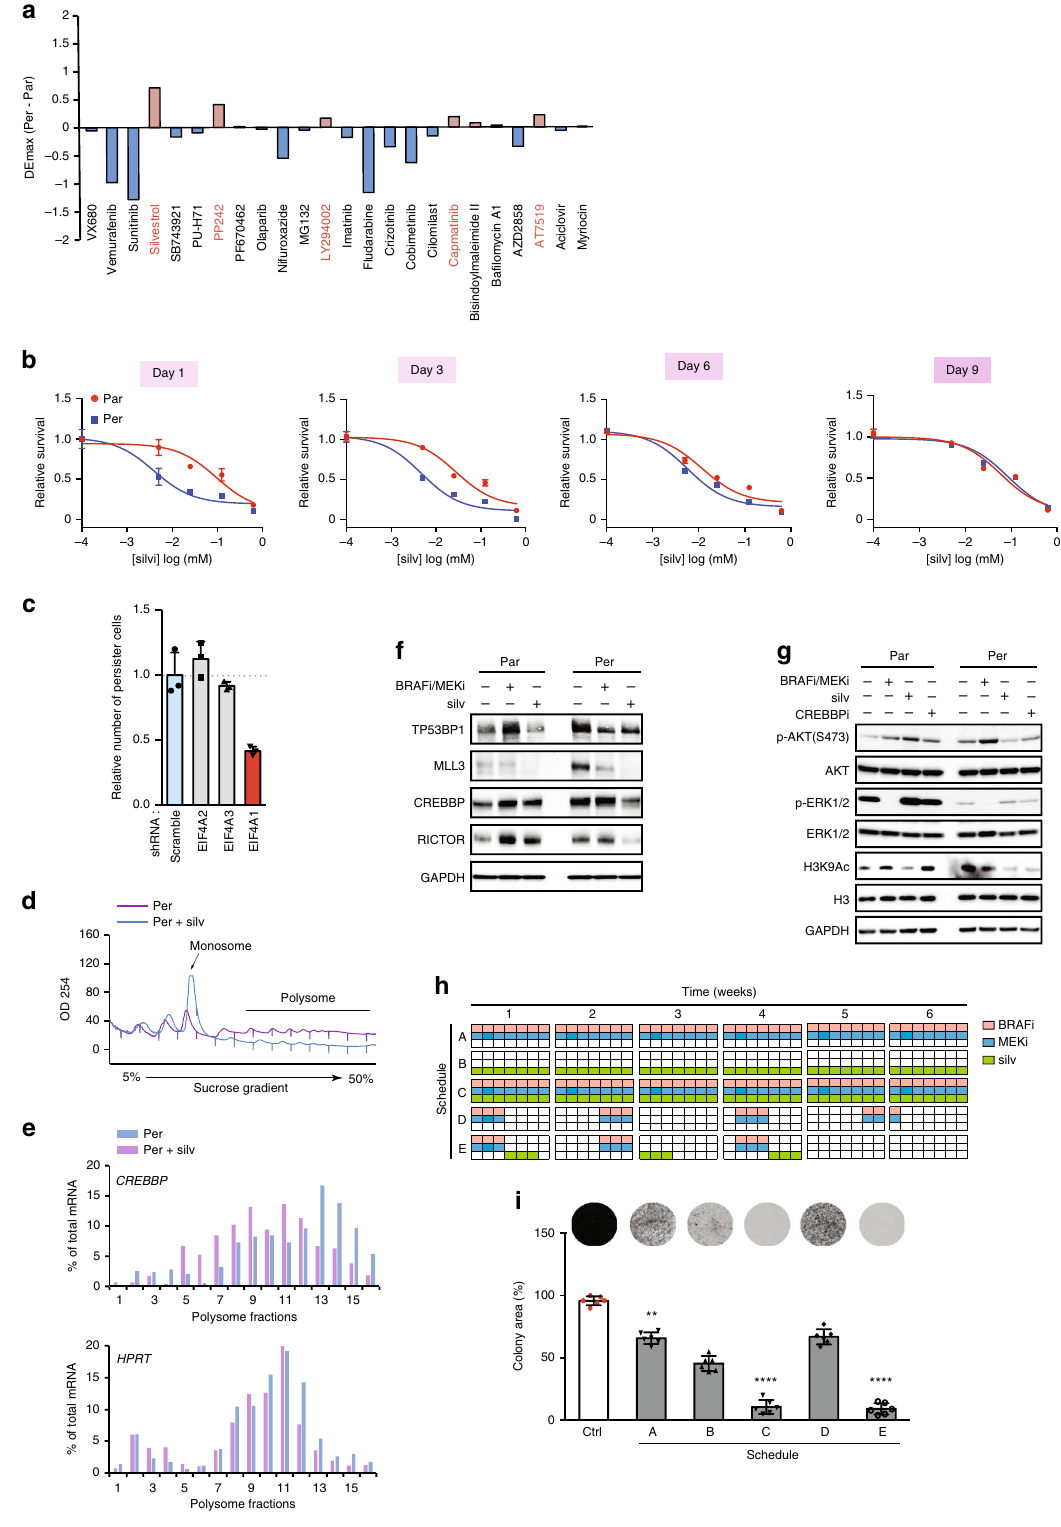
As BRAFi-dependent fi tness of melanoma cells has been We hypothesized that eIF4A inhibition in combination with previously modelled, leading to the proposition of an intermittent BRAFi/MEKi may meaningfully improve outcomes of current BRAFi regimen to maximize the duration of patient response 7 , we targeted therapy in BRAF V600 melanoma, by directly targeting residual persister cells 38 . We thus evaluated the ef fi cacy of tested several regimens with BRAFi/MEKi given continuously or intermittently (schedules A and D, respectively). This was silvestrol combined with BRAFi/MEKi in preventing persister cell compared with silvestrol given as a monotherapy (schedule B) colony formation, by comparing fi ve treatment strategies (Fig. 3h). NATURE COMMUNICATIONS| (2019) 10:5713